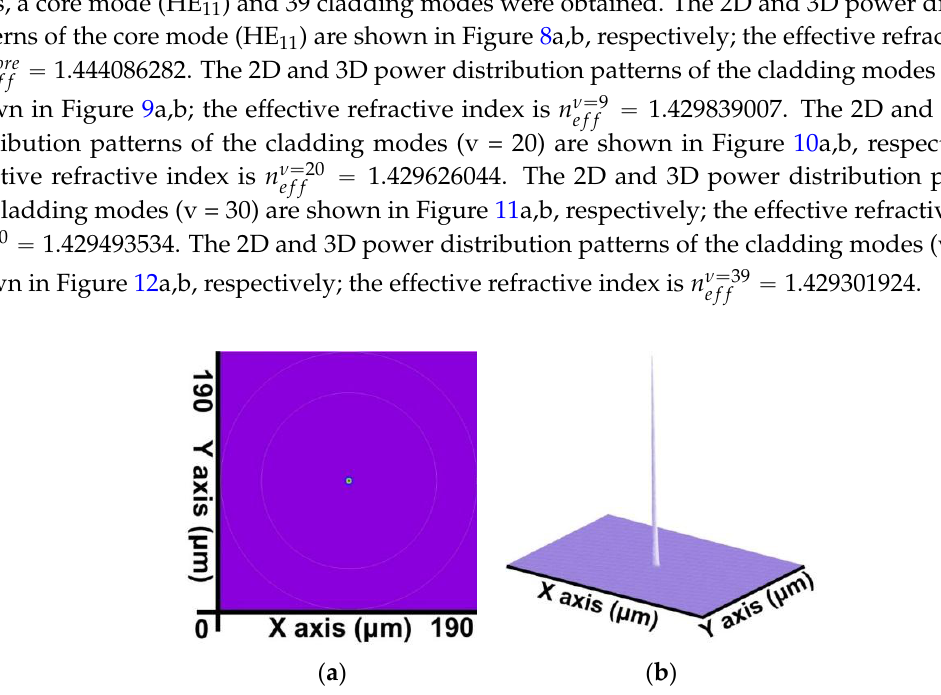
Figure 8. The 2D and 3D power distribution patterns of the core mode (HE 11 ) with an effective refractive index of core eff n “ 1.444086282. ( a ) The 2D power distribution; ( b ) the 3D power distribution.